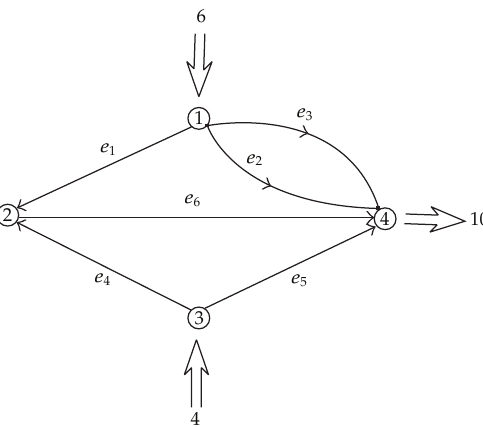
Figure 2: Network topology for an